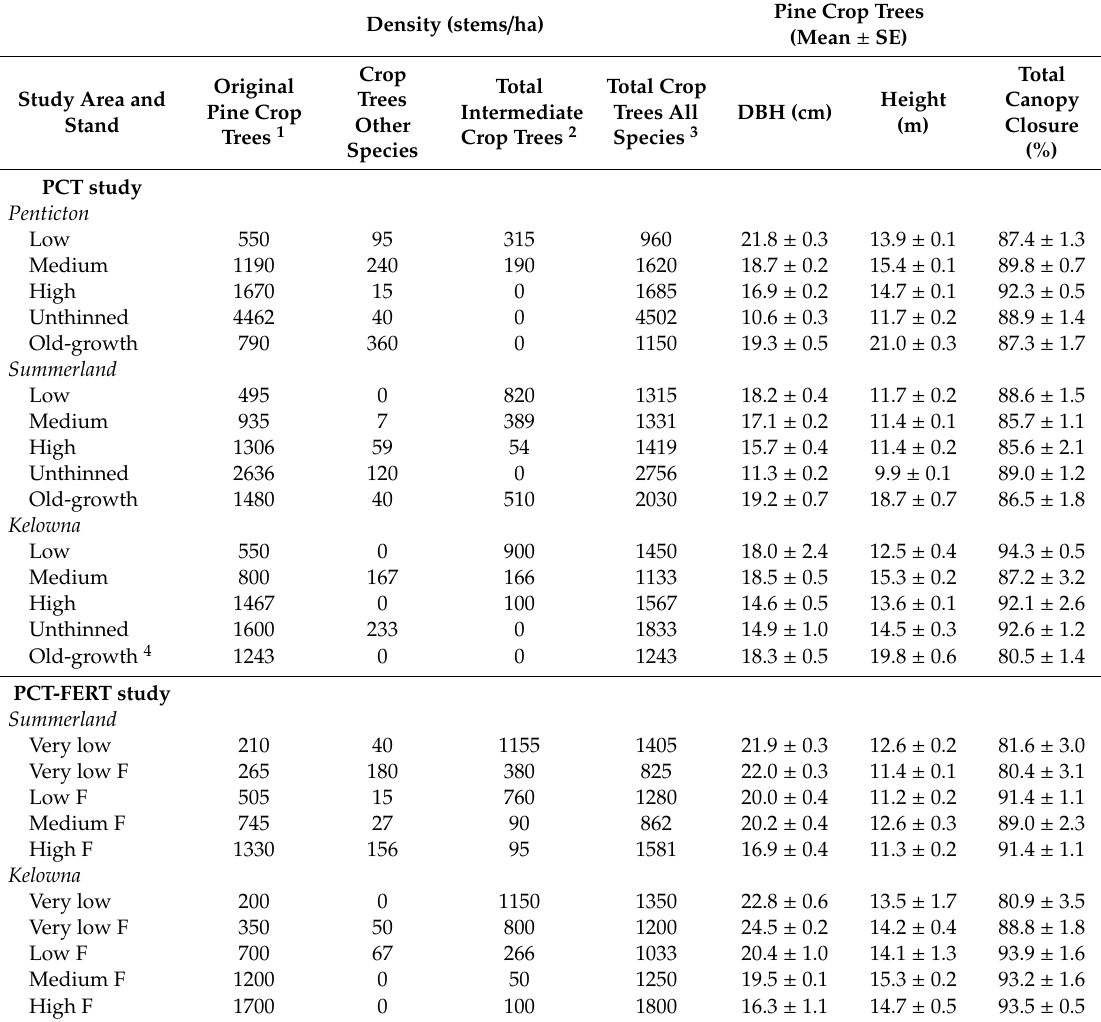
Table 1. Experimental design and characteristics of lodgepole pine stands for the pre-commercial thinning (PCT) and PCT with fertilization (PCT + FERT) studies, 25 years after initiation of treatments.